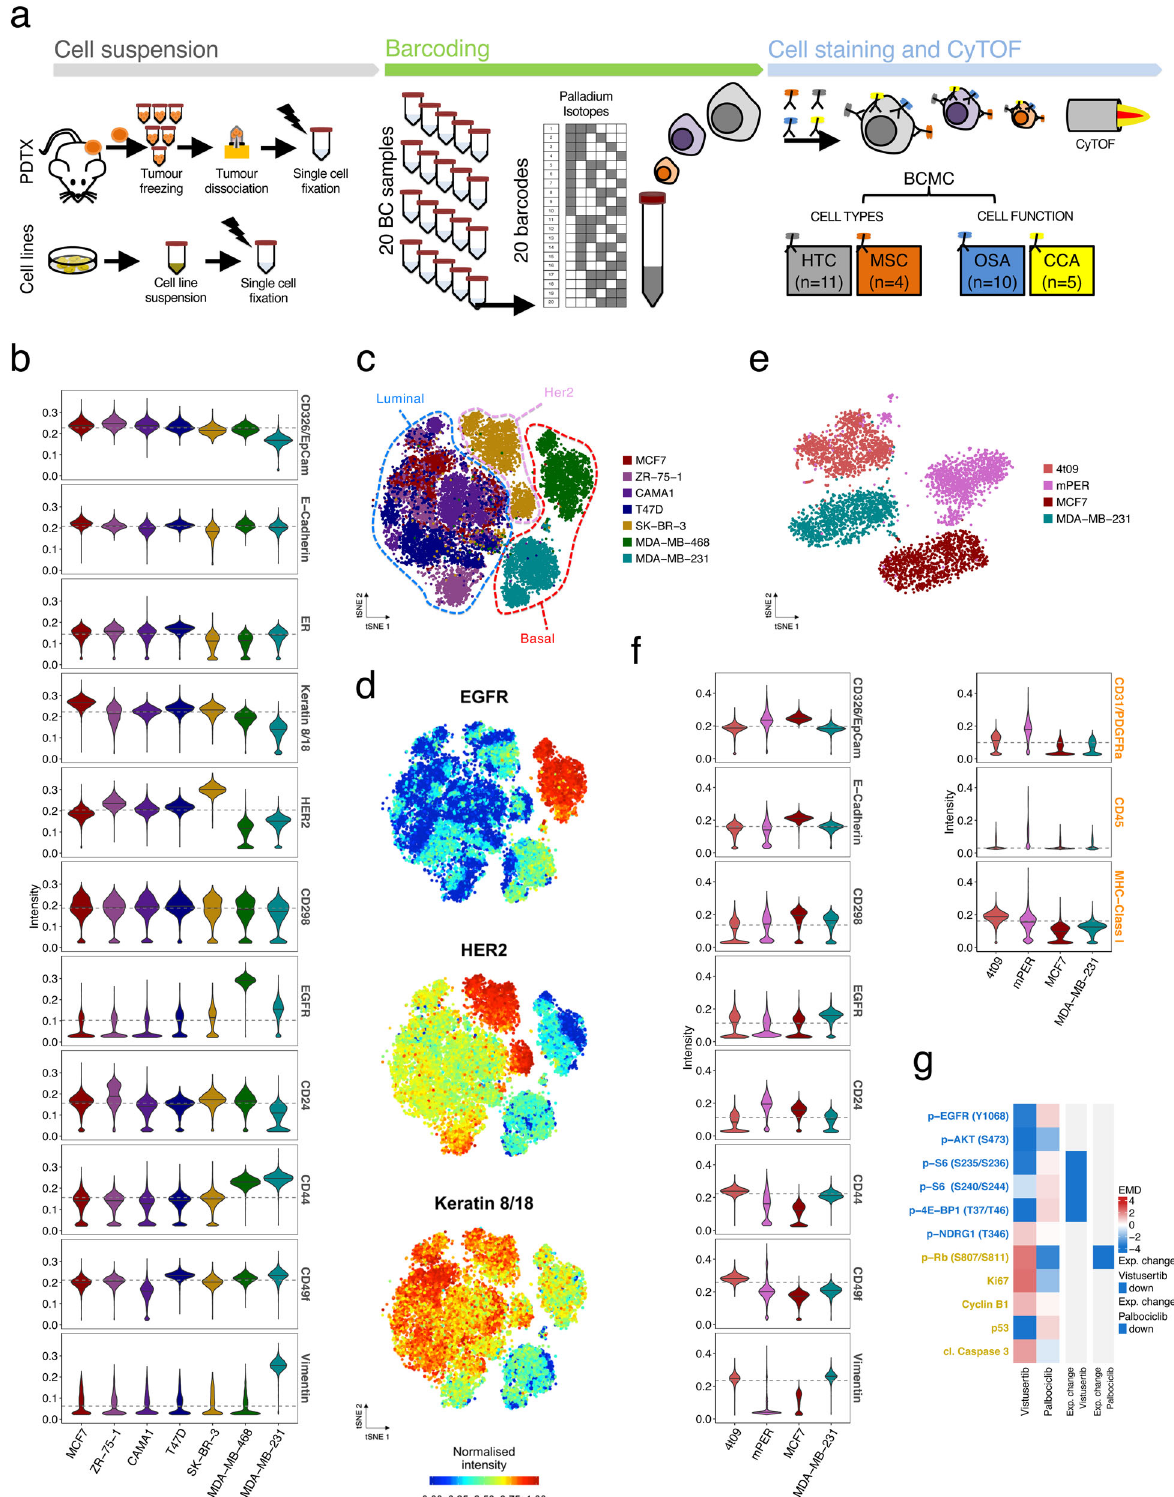
of PDTXs and their matched originating tumours are presented in Supplementary Fig. 2a to highlight their remarkable similarity. The PDTX samples were processed in 3 batched experimental sets (randomised for ER and HER2 status) with two PDTXs (STG139 and AB551) being used as a reference set in all 3 batches to